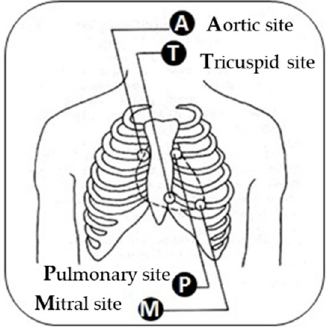
Figure 3. The auscultation sites. ( A ) A ortic site (ECG A ): on the patient’s right side of the sternum. ( P ) P ulmonary site (ECG P ): on the left-hand side of the patient’s sternum. ( T ) T ricuspid site (ECG T ): in the fourth intercostals space, along the lower-left border of the sternum. ( M ) M itral site (ECG M ): along the mid-clavicular line in the fifth intercostal space.